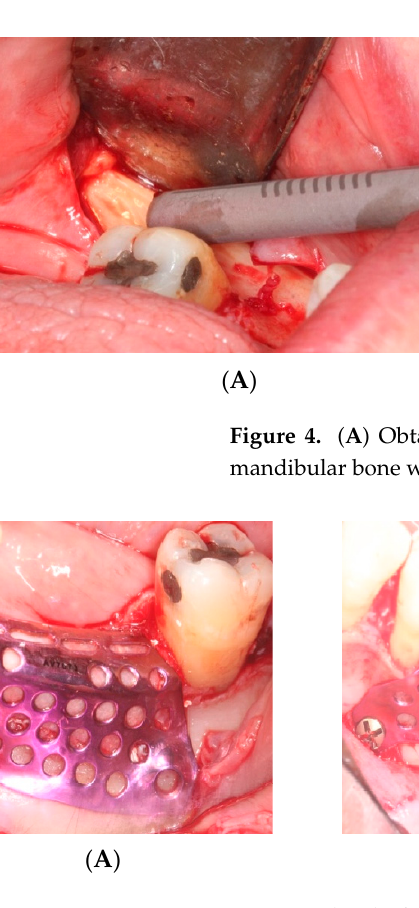
Figure 5. ( A , B ) Placement of the mesh with the biomaterial inside. ( C ) Placement of the collagen membrane outside the titanium